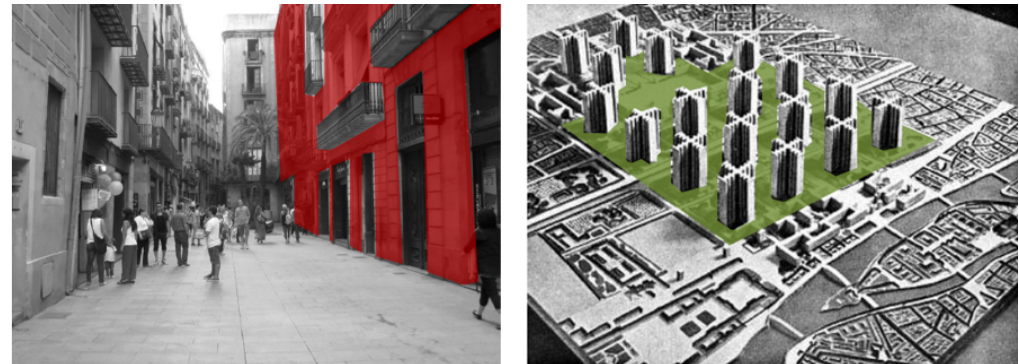
Figure 12. A street in central Barcelona (red) and Le Corbusier ‘s ‘Ville Contemporaine’ (green). Source: K. Braz private collection